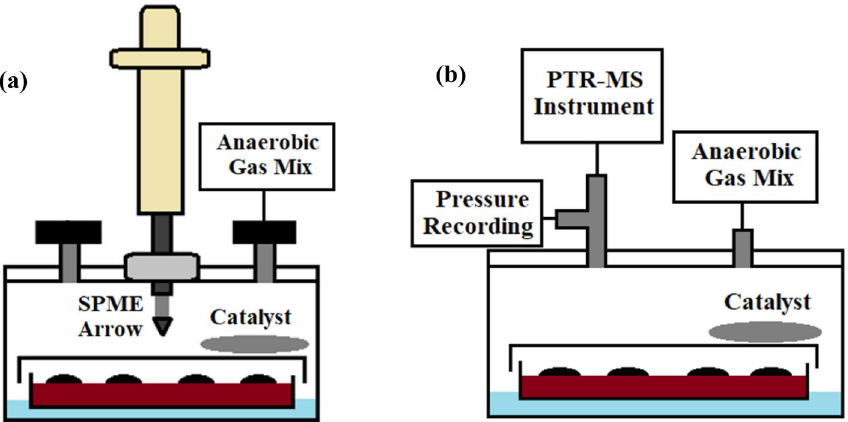
Figure 1. ( a , b ) Schematic representation of the bacterial container designed for bacterial headspace measurements. With anaerobic bacteria, excess oxygen is removed with a palladium catalyst. Distilled, sterilized water at the bottom of the container is used to humidify the headspace and prevent bacterial cultures from drying. ( a ) For the GC–MS measurements, the SPME Arrow is injected through a septum. The inlet and outlet are simple on/off two-way valves. ( b ) For the PTR-MS measurement, a continuous gas flow is passed through the container. The flow is controlled with an external mass flow-controller and electronic valves driven by a computer. The same setup is used for reference measurements, with the bacterial culture replaced with an empty petri dish containing a drop of the pure reference compound. Triplicates of each sample were